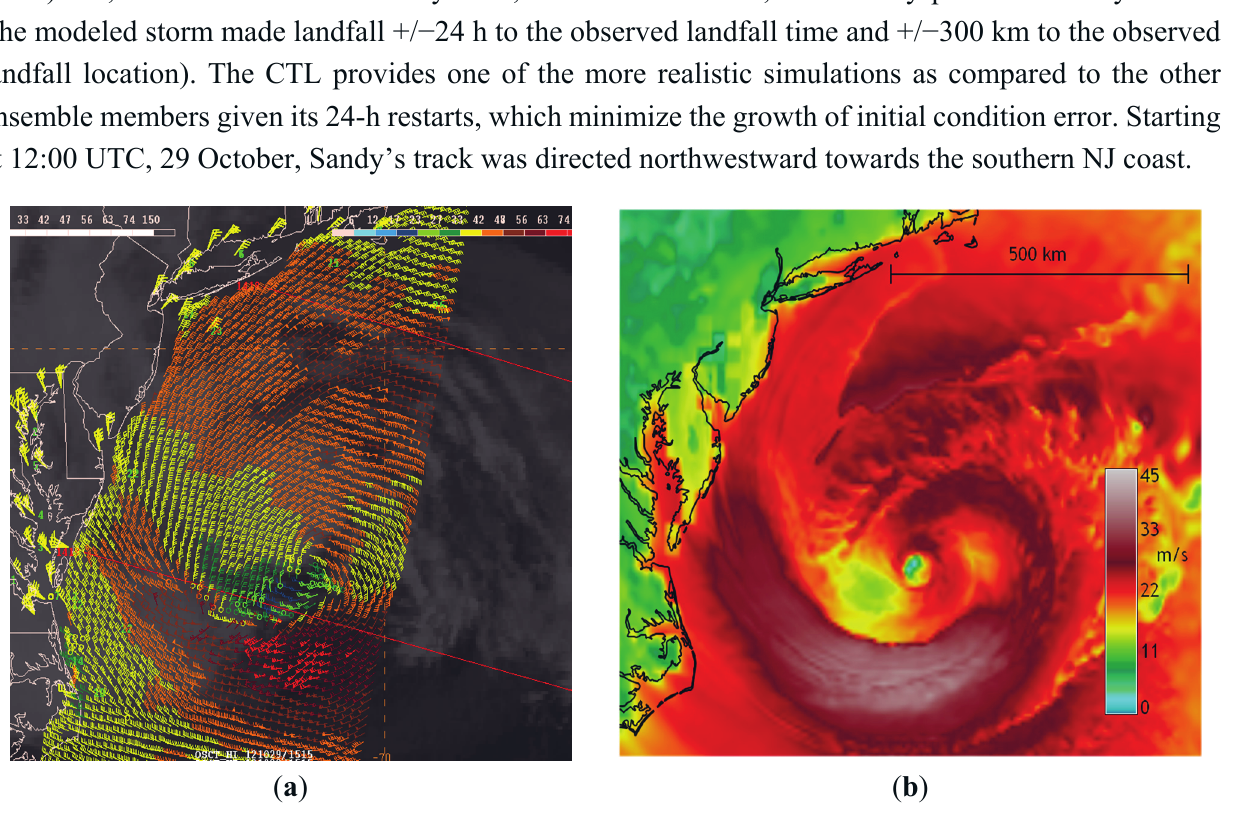
Figure 3. ( a ) Scatterometer surface winds (colored in kts and full barb = 10 kts) at 12:00 UTC, 29 October 2012; ( b ) Same as ( a ) except for the control WRF run (hour 12